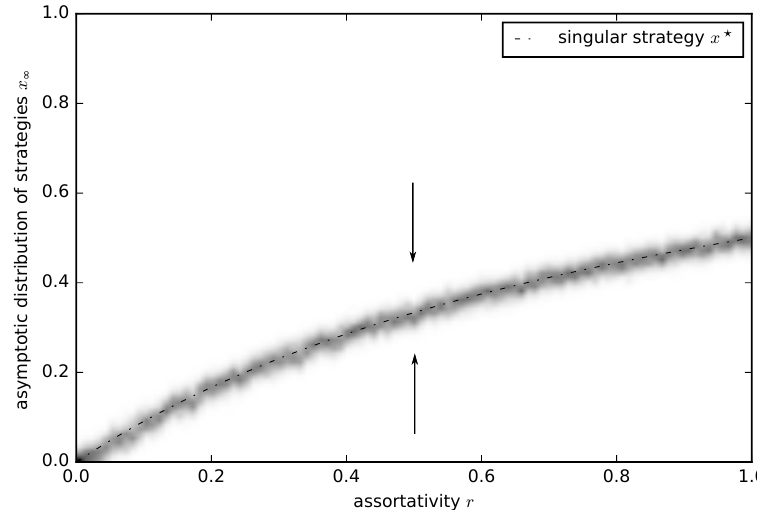
Figure 8. Variation of the distribution of long-term strategy values x ∞ with assortativity r in the CD game with quadratic cost and benefit functions: C ( x ) = x 2 and B ( x ) = − x 2 + 2 x . Parameters: x 0 = 0.1, x m = 1, µ = 0.01, σ = 0.005, and β = 1. Arrows indicate the direction of evolutionary